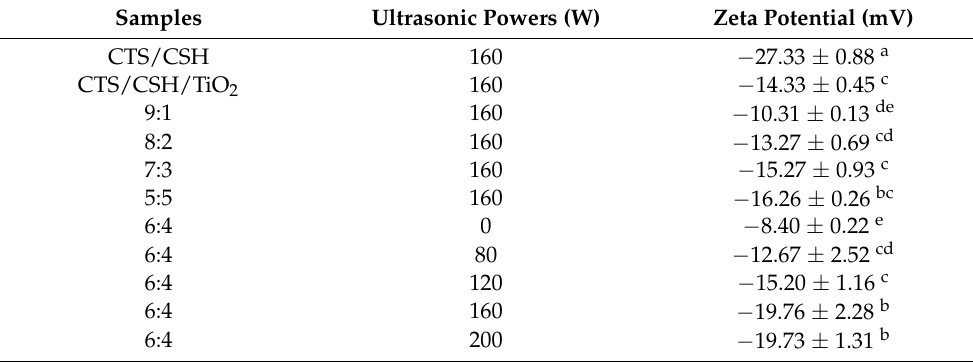
Table 1. Zeta potentials of the CTS/CSH, CTS/CSH/TiO 2 , and various CTS/CSH/TiO 2 /Gr compos- ite